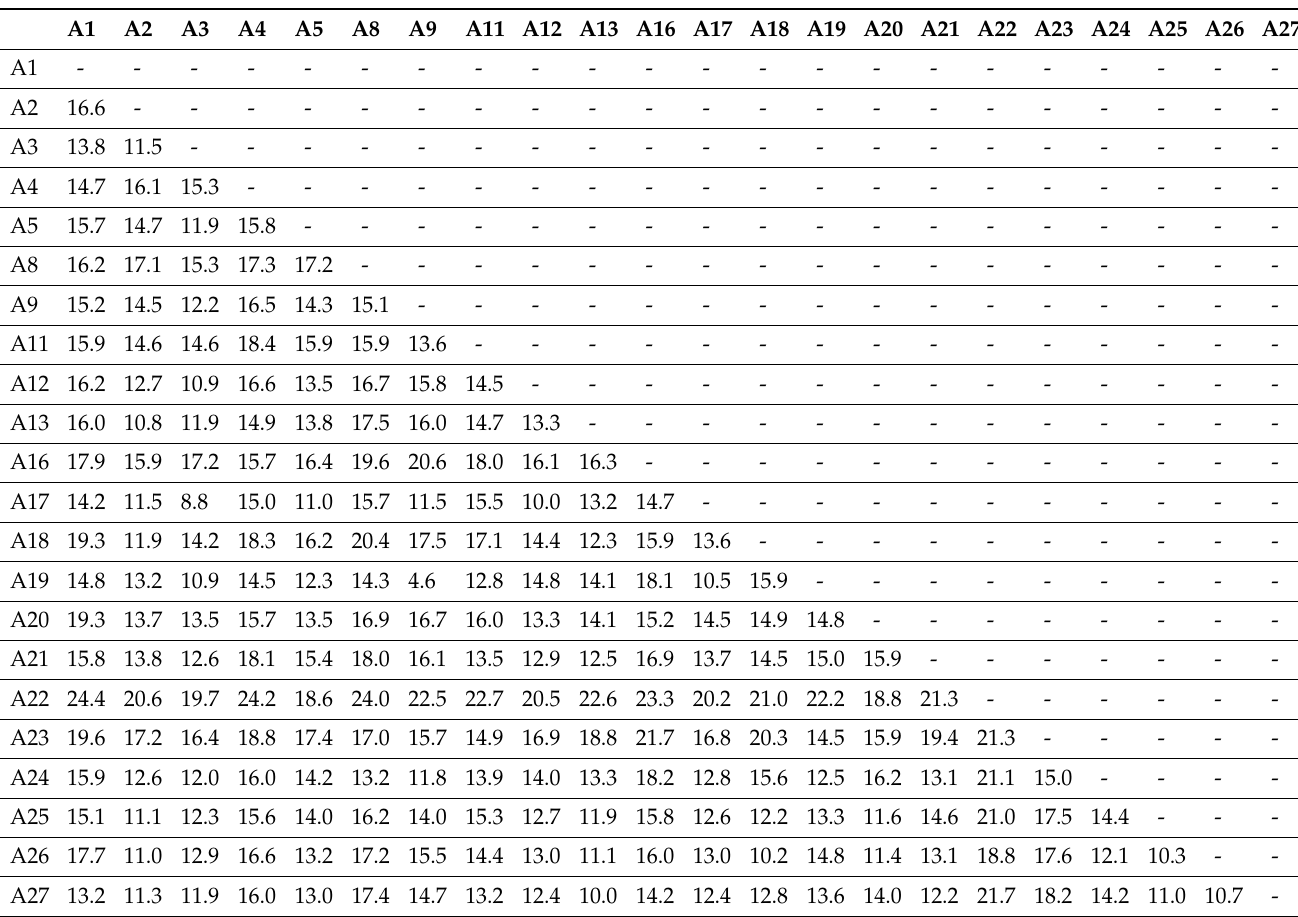
Table 2. Mean pairwise nucleotide genetic distance between subtypes of genotype A (inter-genotype) based on the CA fragment of the gag gene. In the present study, the SRLV subtypes found by Colitti et al. [23] were renamed from A18 to A19 and from A19 to A20, and the subtypes found by Olech et al. [8] were renamed from A23 to A25 and from A24 to